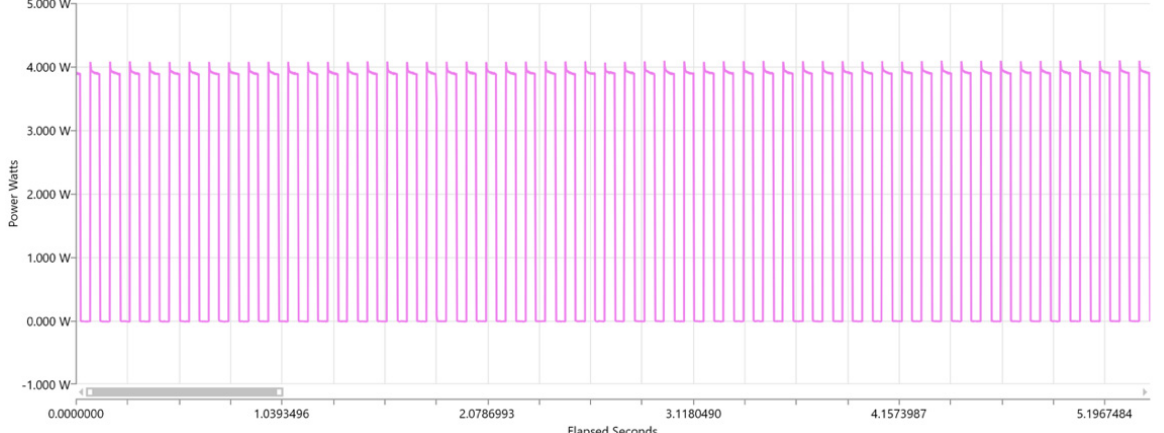
Figure 4. Representative power output of SIROLaser Blue (445 nm) in pulsed mode over 5 s.